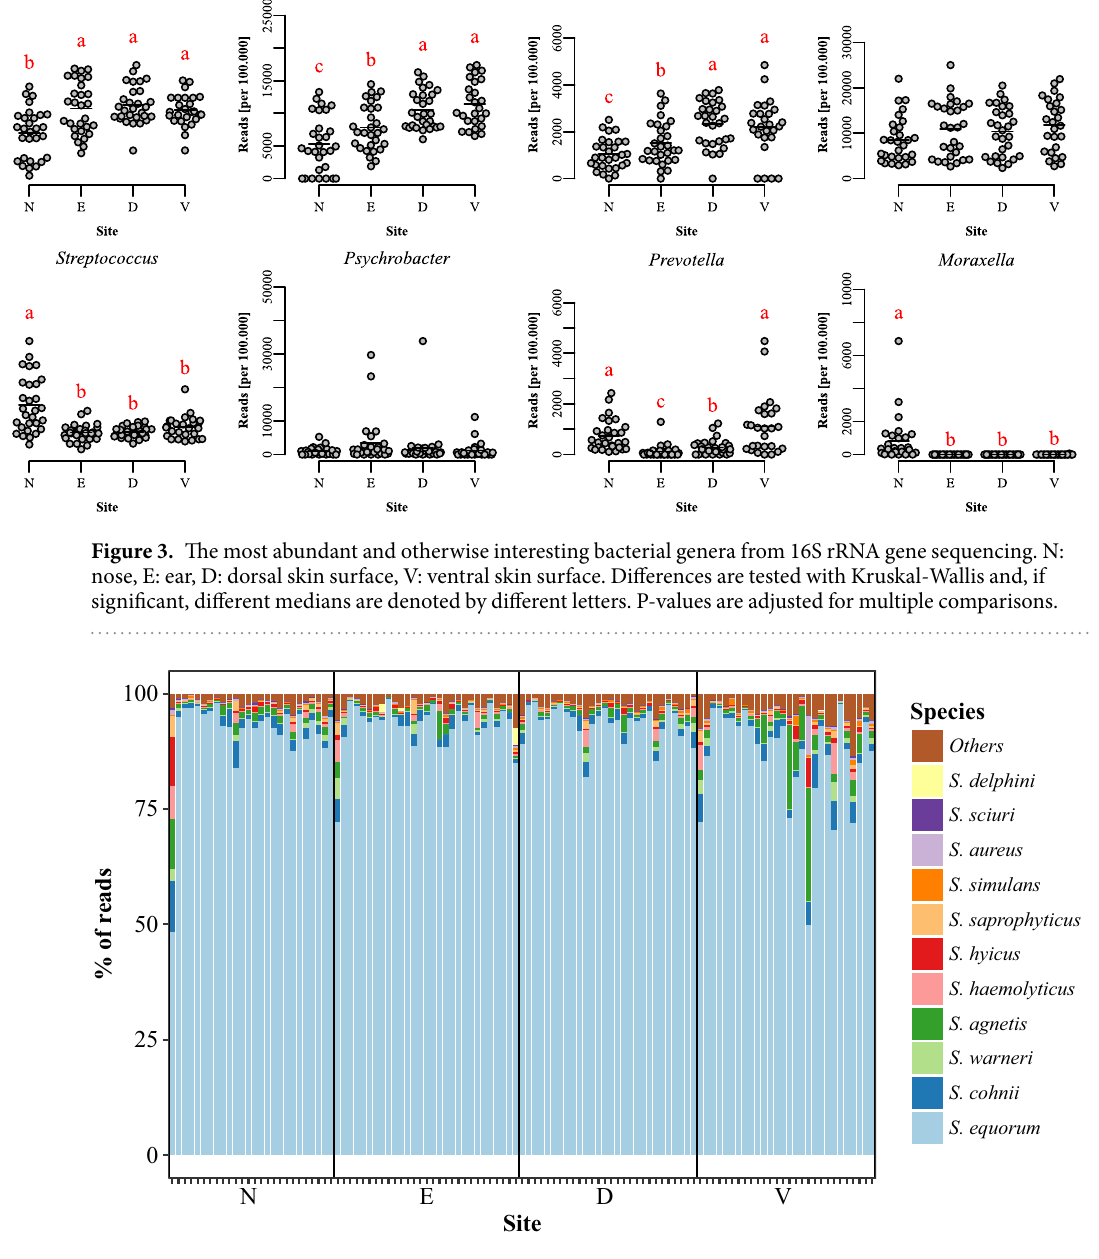
Figure 4. Composition of pig samples using tuf gene primers. Each column corresponds to a single sample in which the relative abundance of bacterial genera is shown through color coding. N: nose, E: ear, D: dorsal skin surface, V: ventral skin